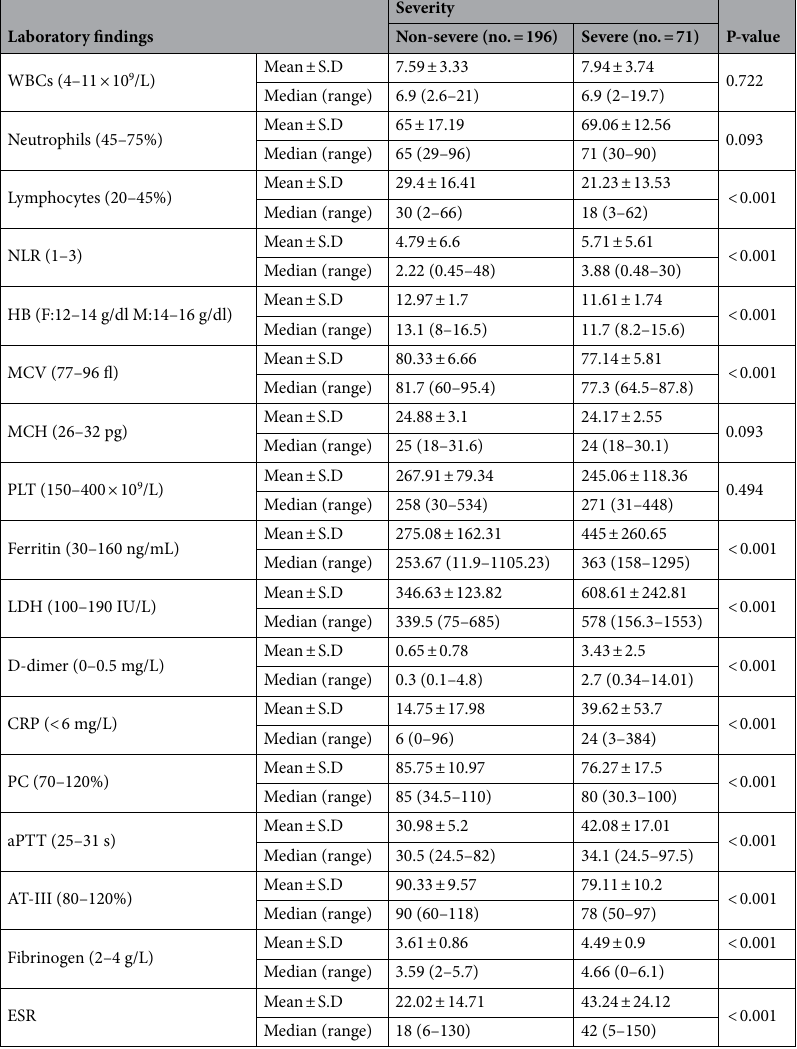
Table 2. The relation between laboratory findings and severity (No. = 267). WBCs white blood cells, Hb hemoglobin, NLR neutrophil-to-lymphocyte ratio, MCV mean corpuscular volume, MCH mean corpuscular hemoglobin, PLT platelets, LDH lactate dehydrogenase, ESR erythrocyte sedimentation rate, CRP C-reactive protein, PC prothrombin concentration, aPTT activated partial thromboplastin, AT-III antithrombin-III. P-value was calculated by Mann Whitney test. P-value < 0.05 is statistically